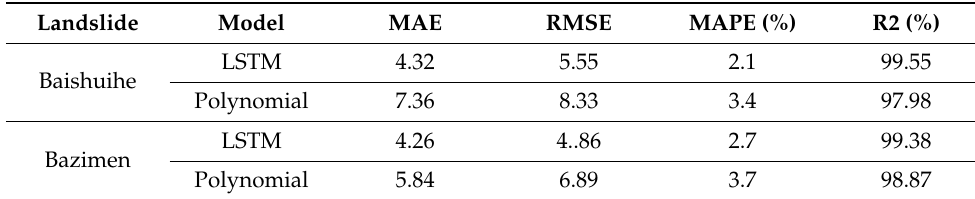
Table 1. Evaluation index results of each model for trend displacement prediction.